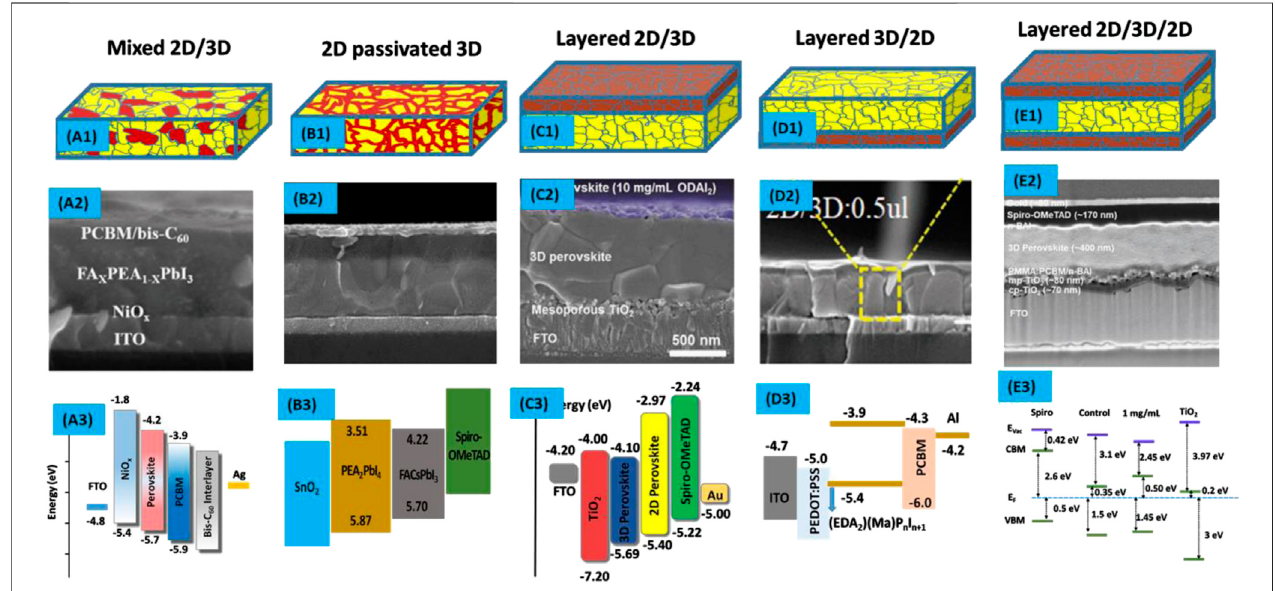
FIGURE 2 | Device structure schematics for 2D/3D multidimensional perovskites serving as an (A) 2D perovskite mixed with 3D perovskite; (B) 2D perovskite passivated 3D perovskite at the grain boundary; (C) 2D perovskite interfacial layer on top of 3D perovskite layer; (D) 2D perovskite interfacial layer at the bottom of 3D perovskite layer; (E) 2D perovskite interfacial layer at both the top and bottom of the 3D perovskite layer. Wherein, (1), (2), and (3) in each category displayed the schematic image, cross-sectional SEM image and related energy diagram, respcetively.